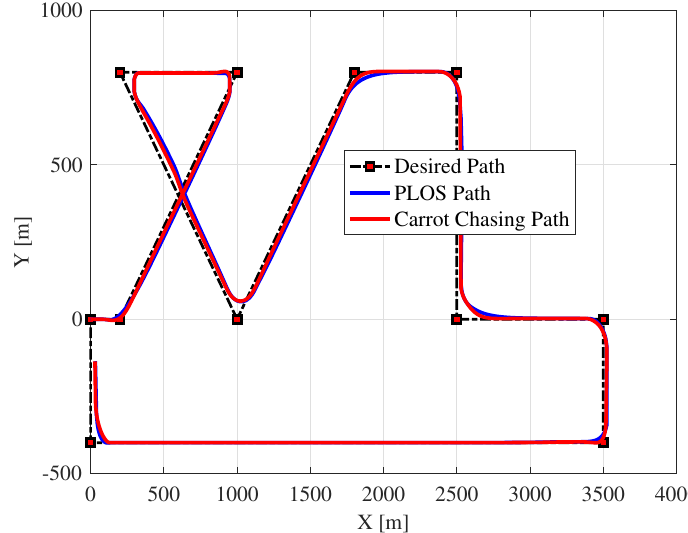
Figure 24. Straight line path following with